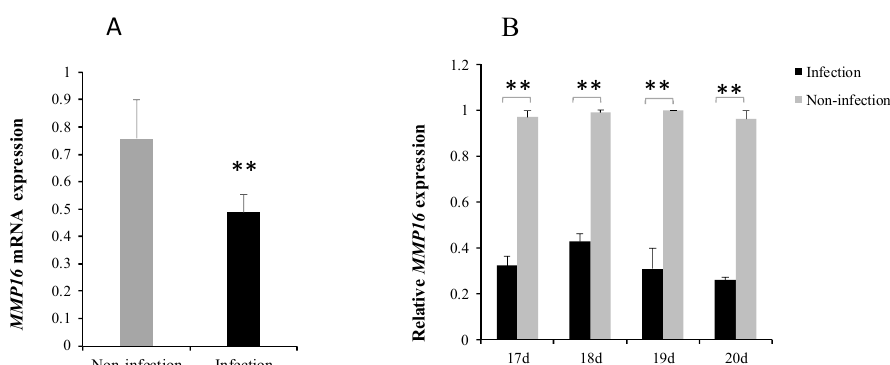
Figure 4. MMP16 expression in DF-1 cells and the lungs of chicken embryos upon MG infection. The expression of MMP16 in DF-1 cells ( A ) and in the lungs tissues on the 8 to 11 days post-infection ( B ) was measured by RT-qPCR and normalized to GAPDH. Uninfected lung tissues and DF-1 cells acted as negative controls. Values are mean ± SD, ** p < 0.01.